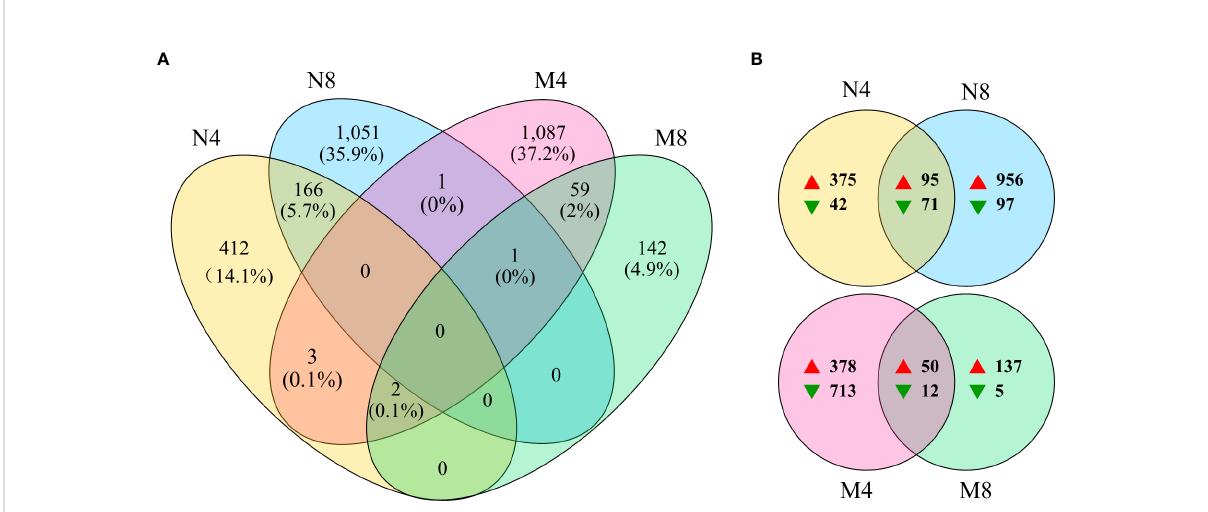
FIGURE 2 Venn diagram of the four comparisons. (A) The overlapped numbers of genes in the four groups. (B) The number of up-regulated (on the right of the red arrows) and down-regulated (on the right of the green arrows) genes in the four groups. N4 and N8 represent the comparison groups of the genes identi fi ed at 4 h and 8 h after treatment to 0 h in Adina. M4 and M8 represent the comparison groups of the genes identi fi ed at 4 h and 8 h after treatment to 0 h in